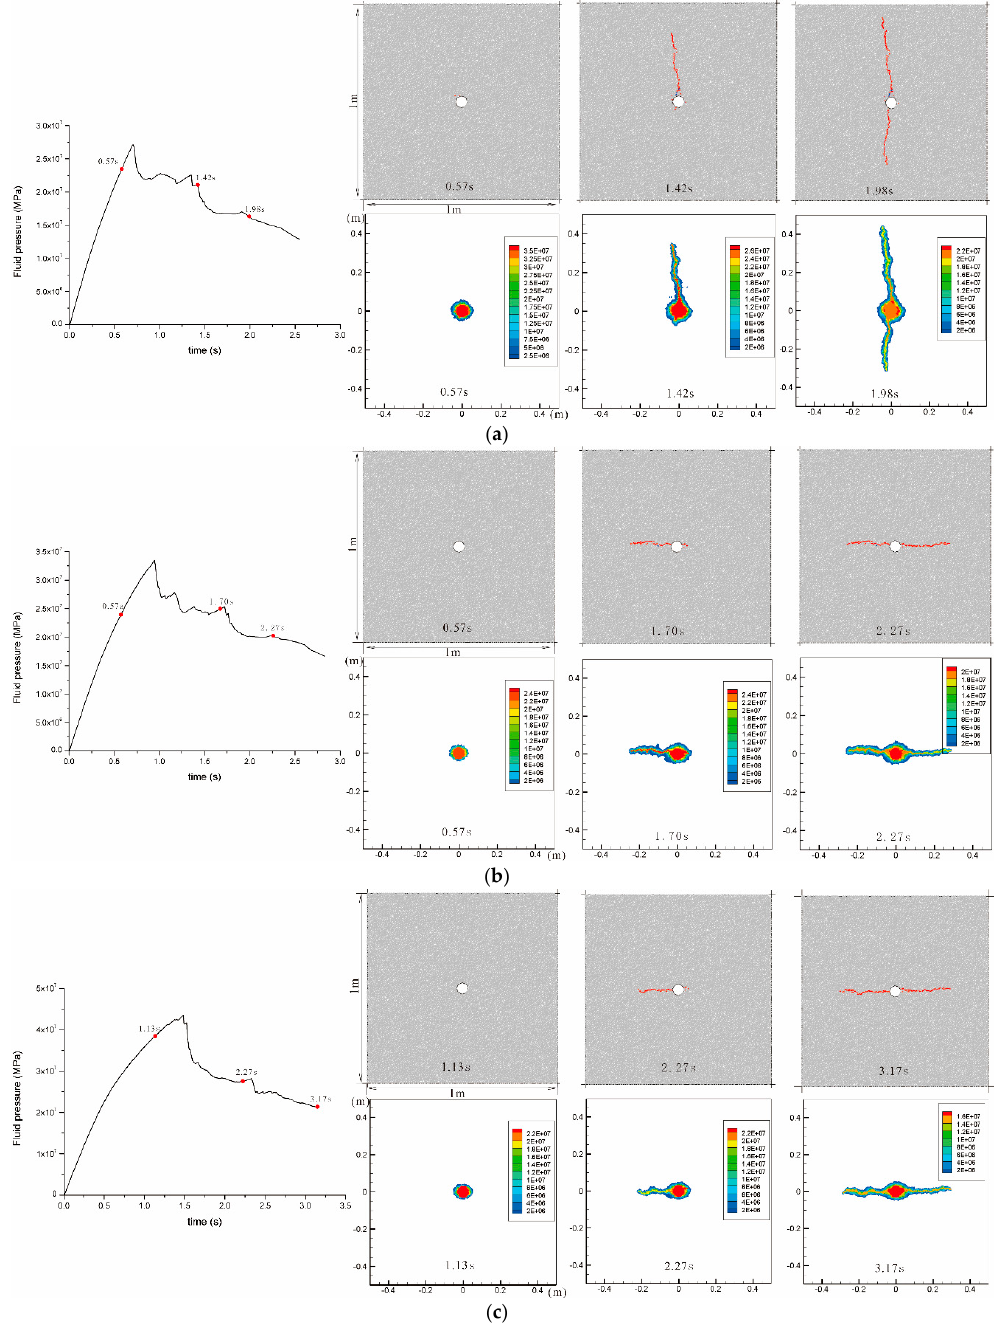
Figure 9. Borehole pressure histories and crack distribution with corresponding pore ‐ pressure field in hydraulic fracturing with an injection rate of 1.0 × 10 − 5 m 3 /s under different in situ stress ratios: As presented in Figure 9a,b, when S H : S h = 20:12 and S H : S h = 20:15, the major fractures stated at the borehole surface in the direction of maximum principle stress (horizontal direction), which can be attributed to the tensile stress concentration at these locations. While S H : S h = 20:20, tensile stress concentration is not distinct because the model is in a hydraulic pressure condition. Thus, the defect in the borehole surface of the PFC model is the main factor for fracture initiation and propagation in